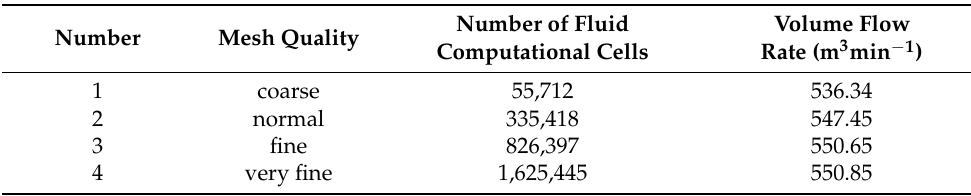
Table 3. Results of numerical grid refinement